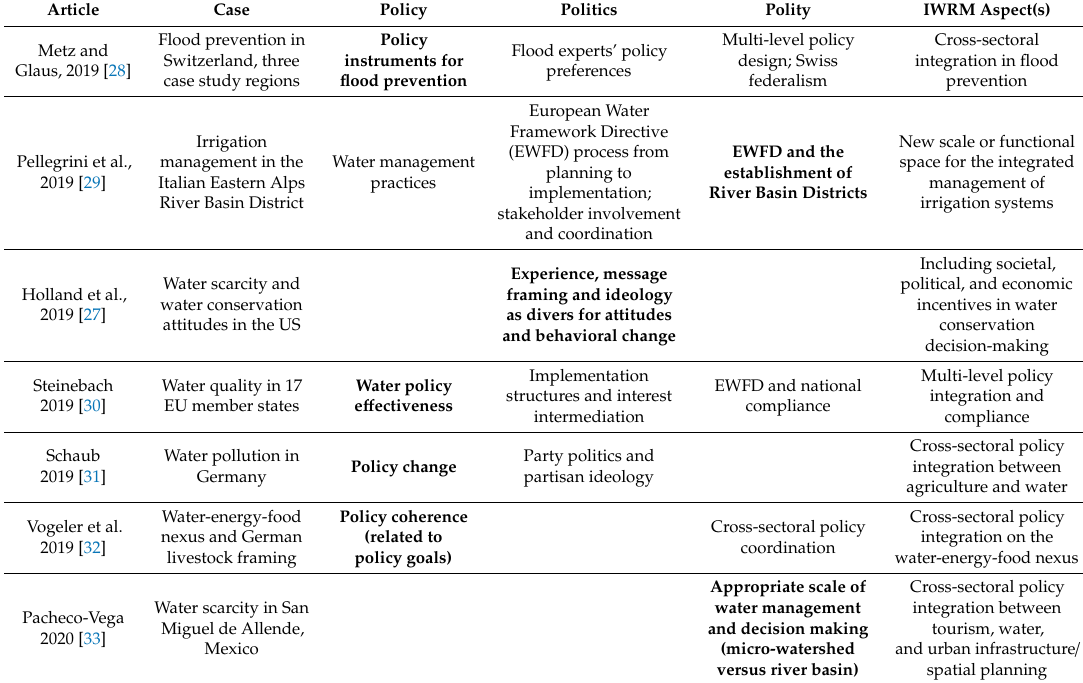
Table 2. Policy analysis dimensions and IWRM aspects of the seven SI